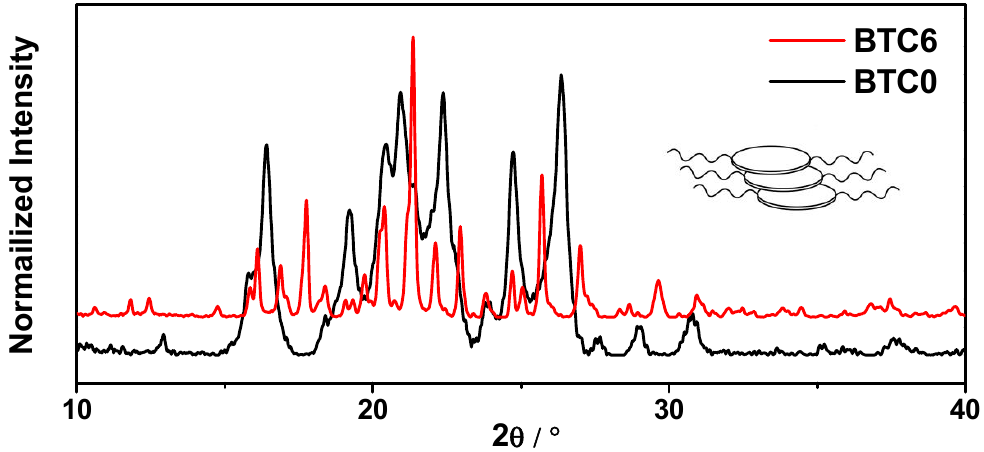
ff raction patterns of BTC0 and BTC6 and model of J -type Figure 3. X-ray diffraction patterns of BTC0 and BTC6 and model of J -type aggregates. Figure 3. X-ray di